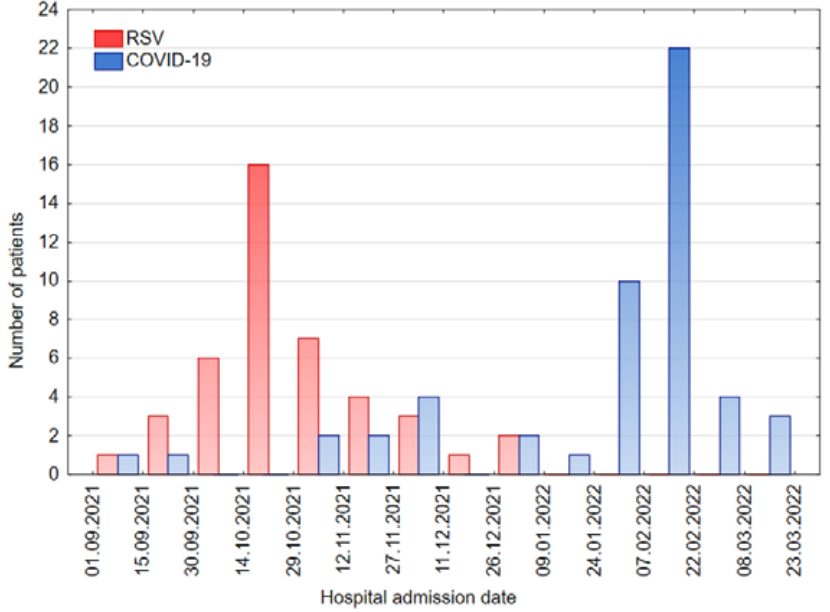
Figure 1. Weekly hospital admissions of patients with COVID-19 and RSV in the winter season of 2021/2022. In total, 43 patients with RSV infection were hospitalized in the peadiatric department in fall and winter season 2021/2022. By contrast, in the season 2020/2021, there were no patients aged 0–36 months hospitalized with RSV infection. The numbers of RSV-diagnosed patients hospitalized in the pediatric department in the previous seasons are presented in Table 2 .